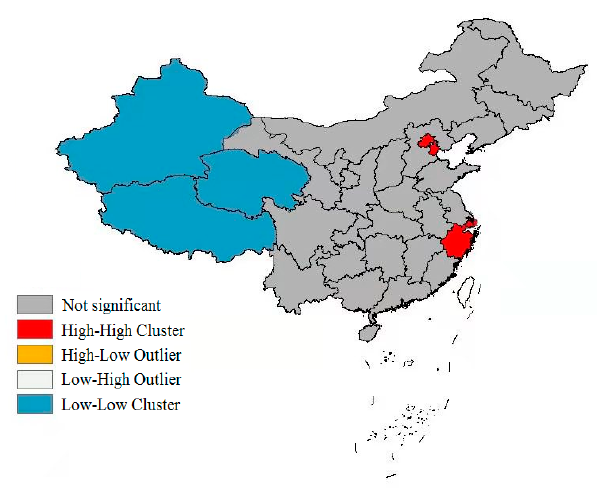
Figure 2. Lisa cluster map of LE in China in 2010.